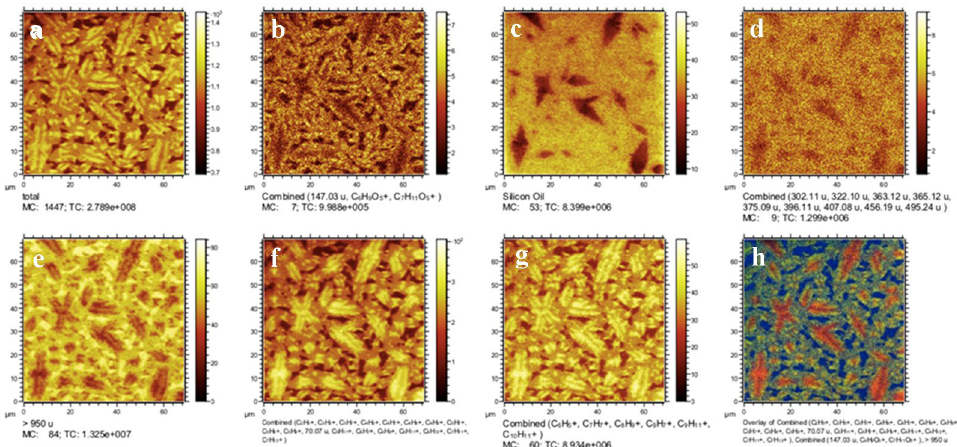
Figure 5. Polarity positive ToF–SIMS images of the bitumen surface highlighting various phases and their corresponding mass and suggested compound. Field of view: 70 × 70 µm 2 . Images created using SurfaceLab7 software. https:// www. iontof. com/ m6- tof- sims- techn ical- detai ls. html#